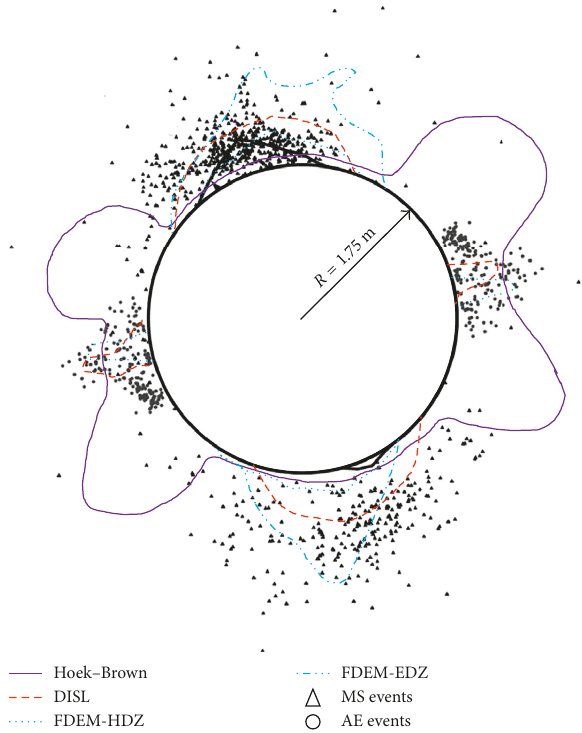
Figure 10: Damage profiles obtained from each intact numerical model (DFN geometries are not integrated in the models): purple continuous line—FEM Hoek–Brown model, red dashed line—FEM- DISL model, blue dotted line—collapsed material of the FDEM model (HDZ), blue dash-dotted line—damaged (fractured) material of the FDEM model (EDZ). In Figure 8, it can be observed that the collapsed material is detaching from the rockmass. On the contrary, the damaged material fractures but maintains its integrity and does not collapse. The results are compared to the actual damaged profile as observed at theURL Test Tunnel[48], and acoustic emission (AE) and microseismic (MS) events are also plotted for comparison [49].